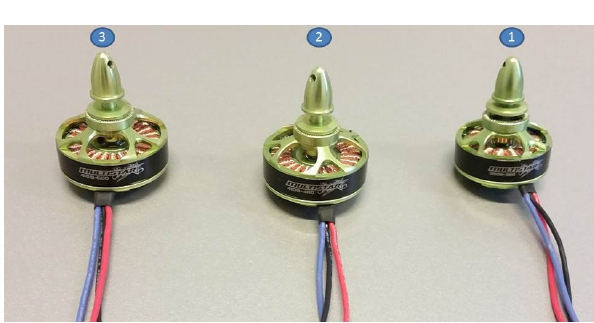
Figure 5: Three different motors used in the design op- timization and validation tests.